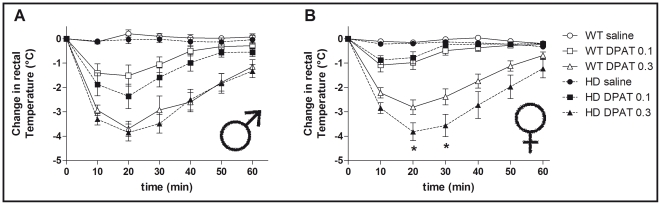
Effect of sex and HD mutation on 8-OH-DPAT-induced hypothermia.Acute injection with the 5-HT1A receptor agonist 8-OH-DPAT (0.1 and 0.3 mg/kg, s.c.), decreased rectal temperatures in a dose-dependent manner in both (A) male and (B) female mice when compared to saline-treated animals. However, only female HD mice exhibited an augmented response to the high dose of 8-OH-DPAT (0.3 mg/kg). The maximum hypothermic response to 8-OH-DPAT was observed 20 min post-injection in both WT/HD male (−3.69±0.31 and −3.85±0.35°C respectively) and WT/HD female (−2.81±0.30 and −3.88±0.36°C respectively, p<0.05). Values are expressed as change of temperature (°C) compared to baseline and represent means (± SEM) of n = 8–14 mice per group. WT vs. HD: (*) p<0.05.